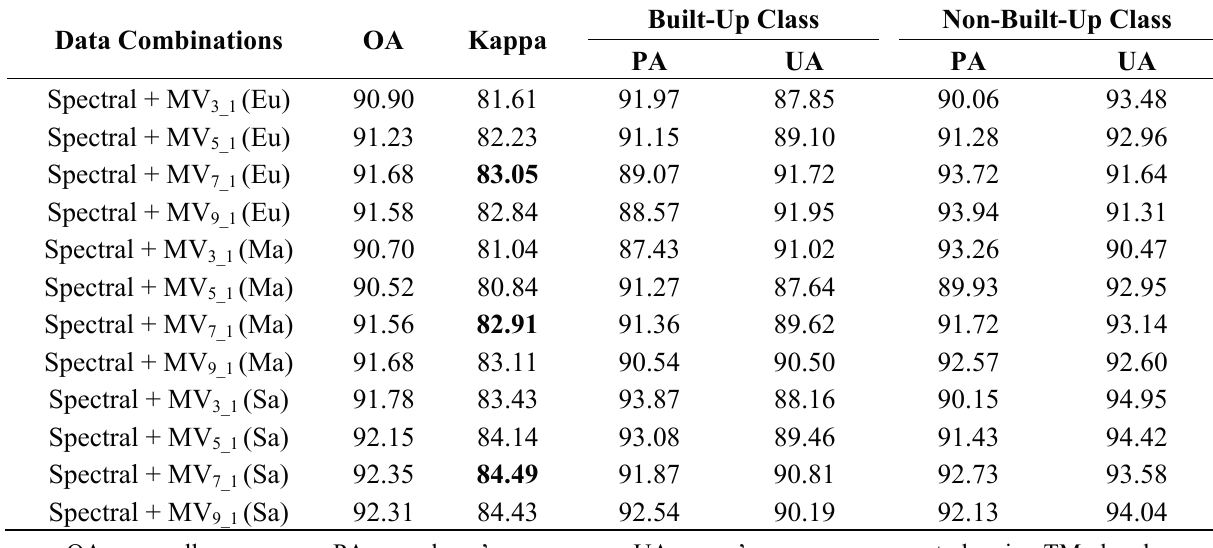
Table 2. Classification accuracies using spectral data and multivariate variogram texture data extracted with different window sizes for the 2005 image of the Beijing area (all in